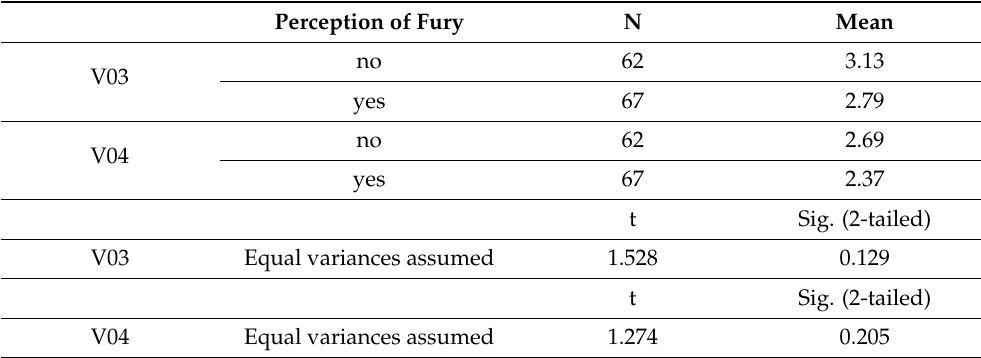
Table 12. Comparison (considering V03 and V04) between those who did not have a perception of fury attack (no) and those who had the perception of fury attack (yes).